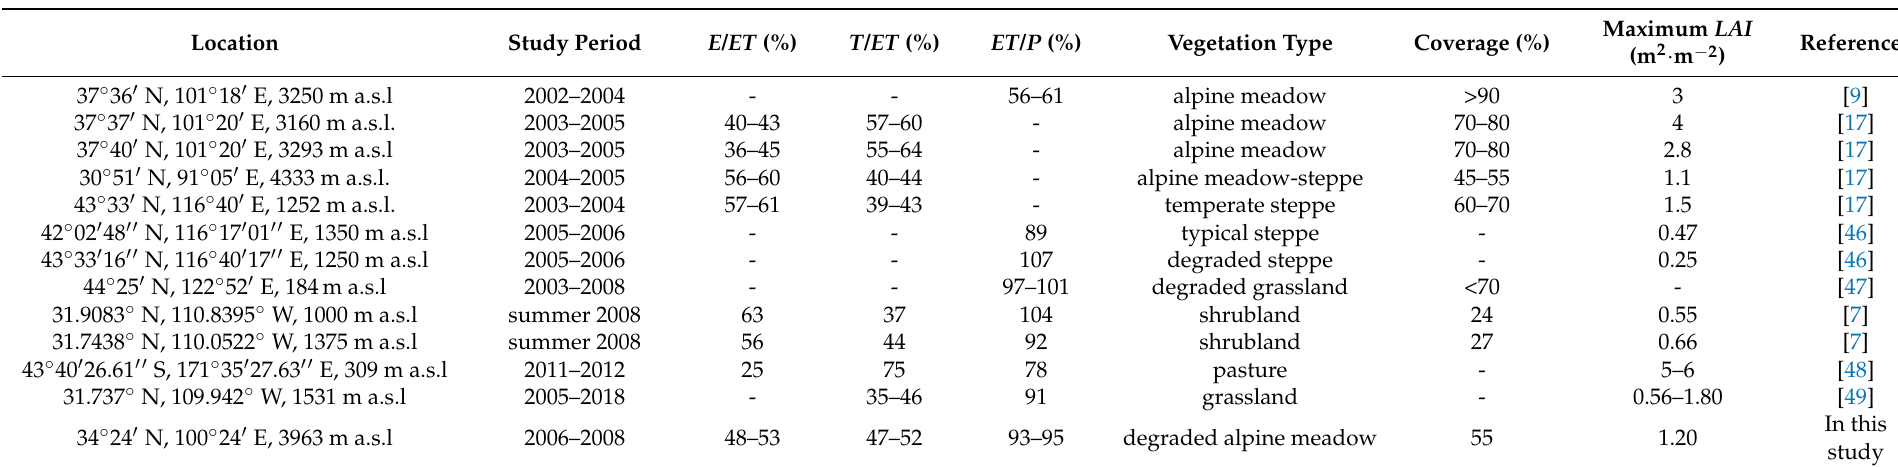
E / ET , the ratio of soil evaporation to evapotranspiration; T / ET , the ratio of plant transpiration to evapotranspiration; ET / P , the ratio of evapotranspiration to